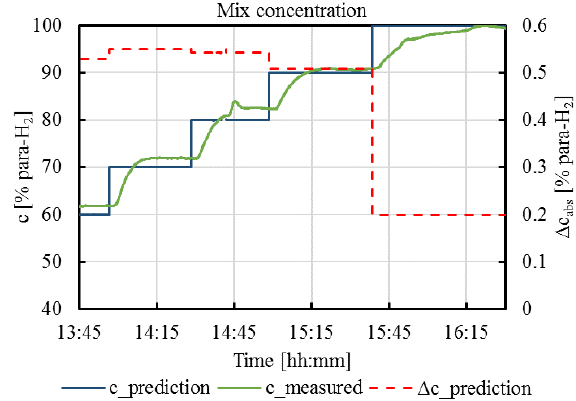
Figure 6. Para concentration during mixing test. The prediction is based on the measured partial mass flows and assumed concentrations of 99.9% para-H 2 and 25.0% para-H 2 respectively. The absolute prediction error is based on errors in the partial mass flows and an assumed absolute error of 0.2% para-H 2 after catalyst. The measured values are based on the speed of sound measurement calibrated using normal-H 2 and para-H 2 as reference